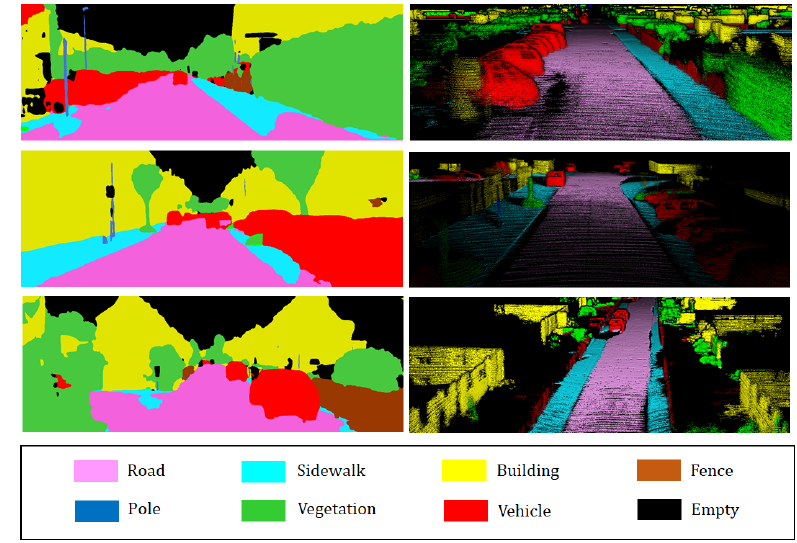
Figure 9. Comparison of 2D semantic segmentation and 3D semantic